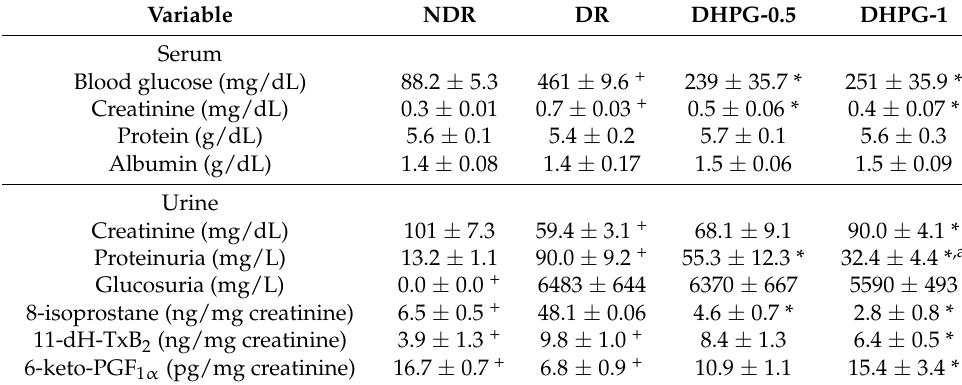
Table 2. Serum and urine variables (mean ± standard error of the mean) of non-diabetic rats (NDR). Diabetic control rats (DR) and DR were treated with 3 (cid:48) ,4 (cid:48) -dihidroxifenilglicol (DHPG) 0.5 or 1 mg/kg/day p.o. (DHPG-0.5. N = 10 rats per